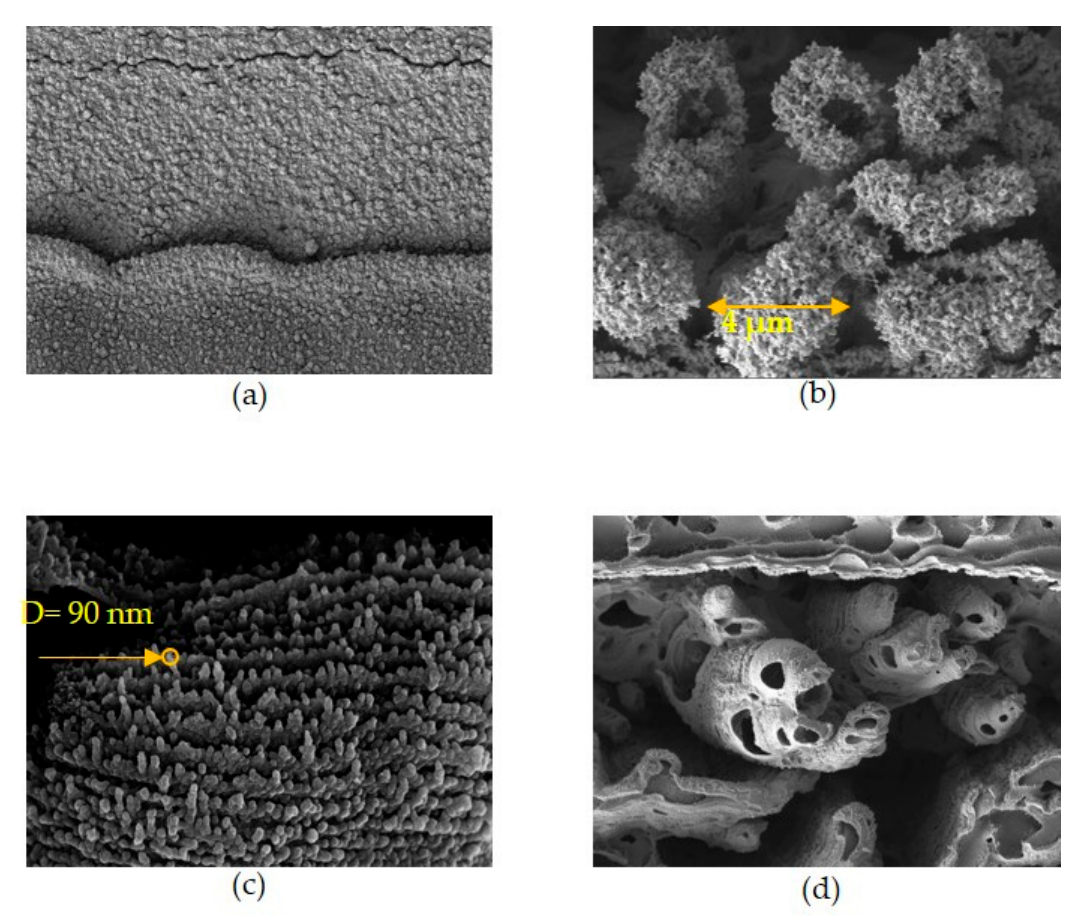
Figure 4. Laser fluence-dependent SEM images of LIG pattern; laser fluence of ( a ) 5.6 J / cm 2 ; ( b ) 5.9 J / cm 2 ; ( c ) 6.4 J / cm 2 ; ( d ) 7.4 J / cm 2 .